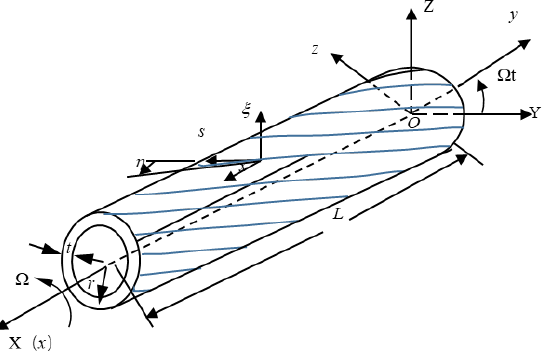
Figure 1. Coordinate systems and geometry of rotating bar.